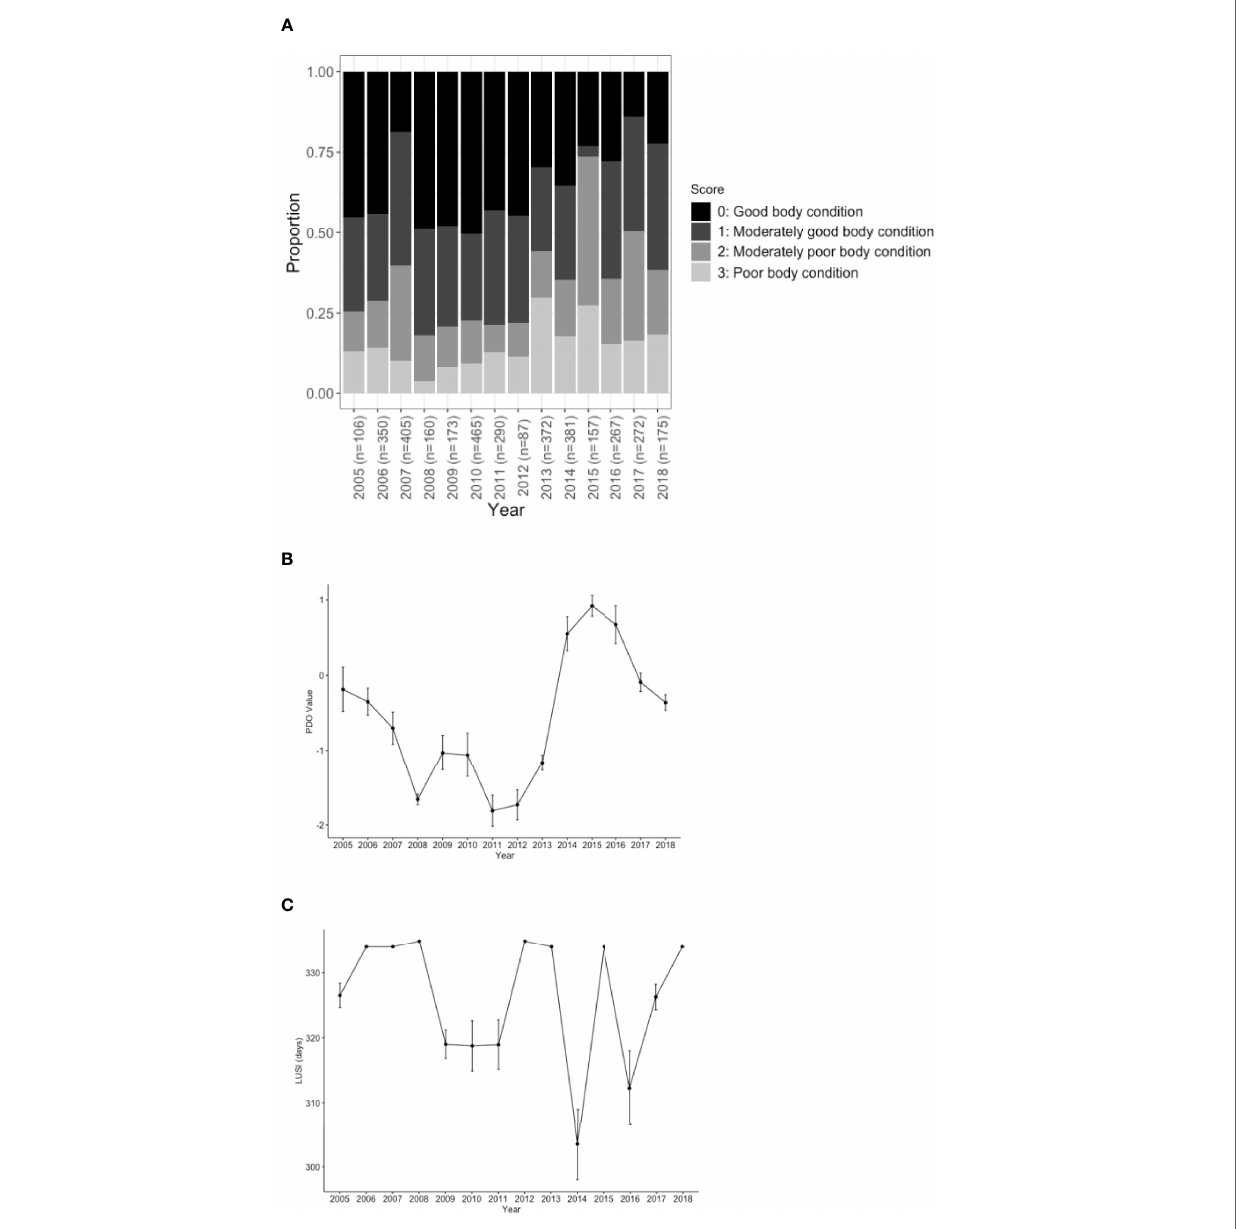
FIGURE 3 | (A) the proportion of each body condition by year as a stacked bar graph compared to (B) average Paci fi c Decadal Oscillation (PDO) value (C) and the length of the upwelling season (LUSI). The marine heat wave occurred from 2014-2016. Error bars show standard